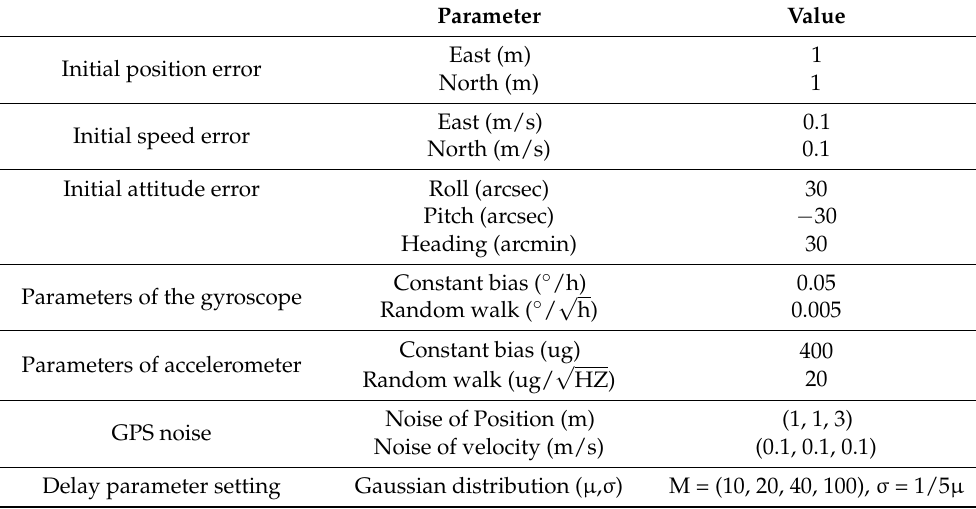
Figure 7. Simulated angle and velocity information.